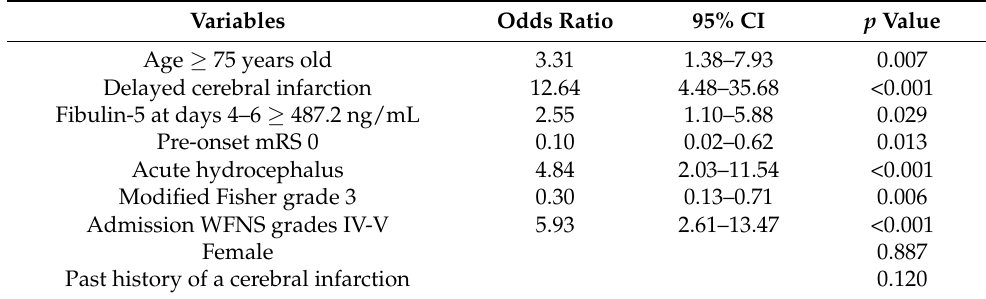
Table 2. Multivariate logistic regression analyses for predicting a 90-day poor outcome after a subarachnoid